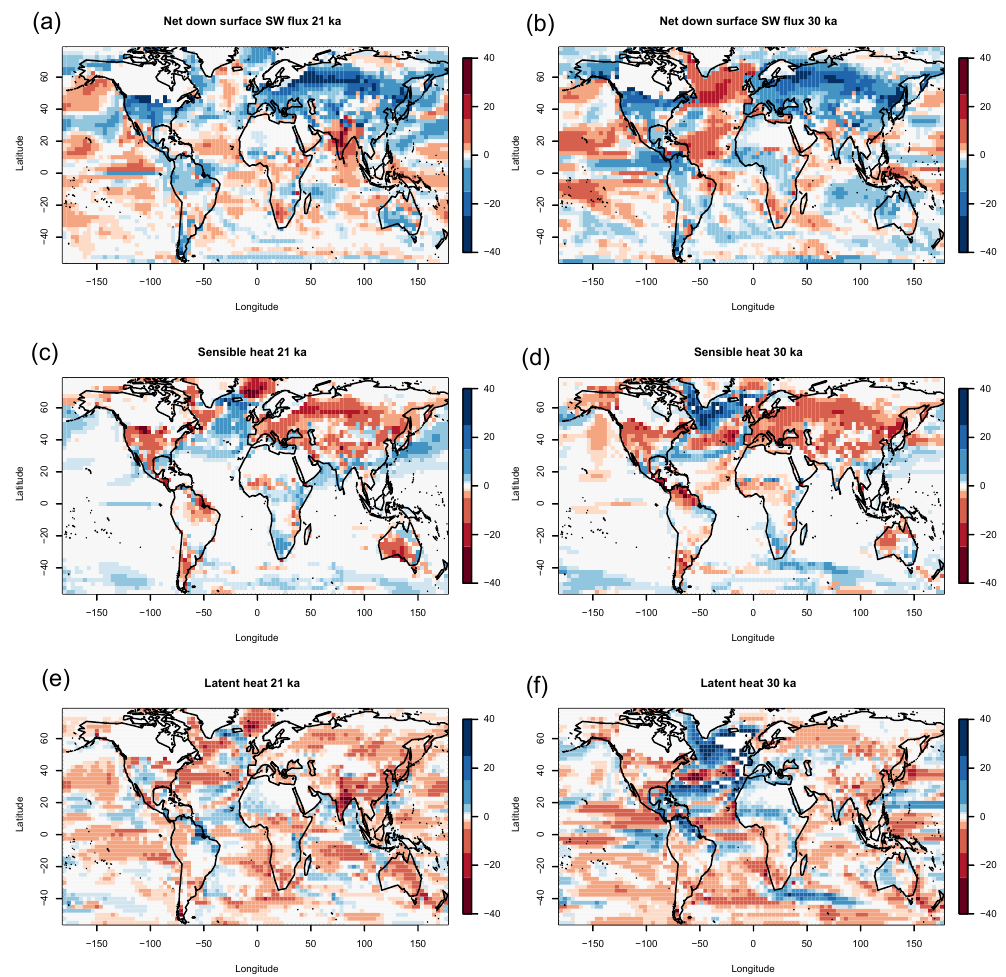
Figure A2. Maps of mean annual anomalies between Dynamic and Static simulations for net downward shortwave flux, sensible heat, and latent heat, for the 21 and 30kyr